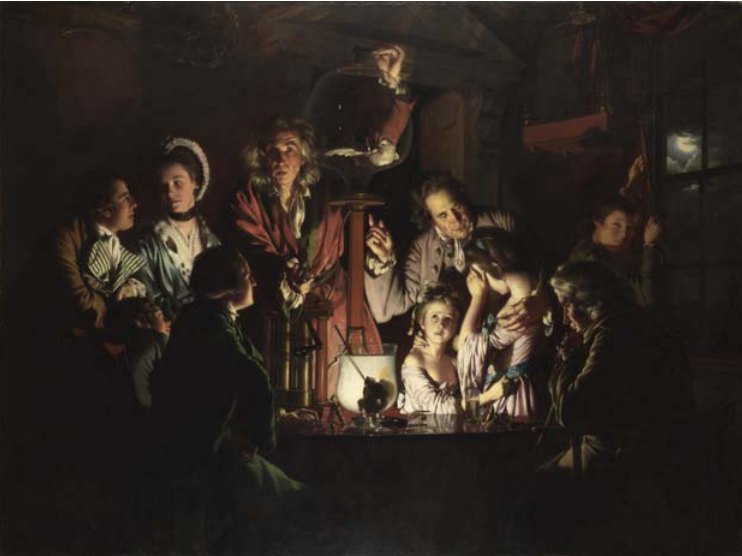
Figure 2. “An Experiment on a Bird in an air pump”, by Joseph Wright of Derby (detail) (1768). In this brilliant artwork, the artist captures the multiple reactions elicited by the use of live animals as experimental subjects in eighteenth-century Britain, for which we can find a parallel in present day’s diverse attitudes on this topic, including shock, sadness, appreciation, curiosity and indifference. Currently in The National Gallery ,